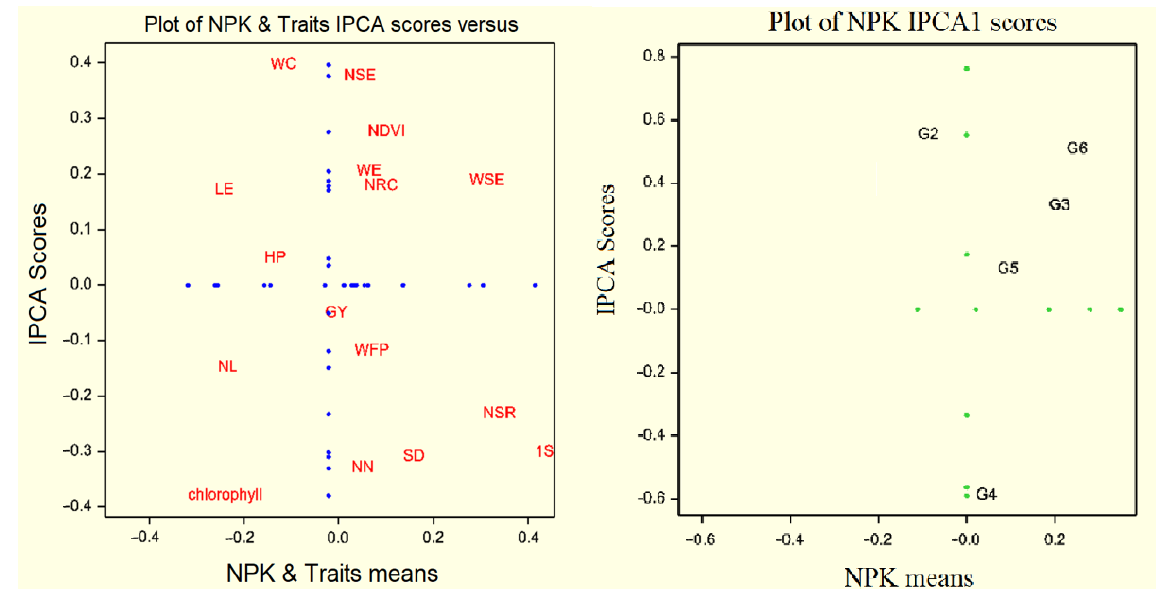
Figure 2. Biplot average traits and NPK of hybrid FAO410 on different treatment levels at principal component values (AMMI). Chlorophyll (Chl), NDVI (NDV), plant height (HP), leaf number (LN), stem diameter (SD), diameter of ear (OED), node number (NN), weight of ear (WE), weight of cob corn (WC), weight of ear (WE), weight of cob (WC), number of seeds in row (NSR), number of seeds per column (NSC), length of ear (LE), weight of all seeds in ear (WSE), number of seeds per ear (NSE), weight of fresh plant (WFP), weight of 1000 seeds (1S), grain yield (GY). G0 until G5 treatments NPK.